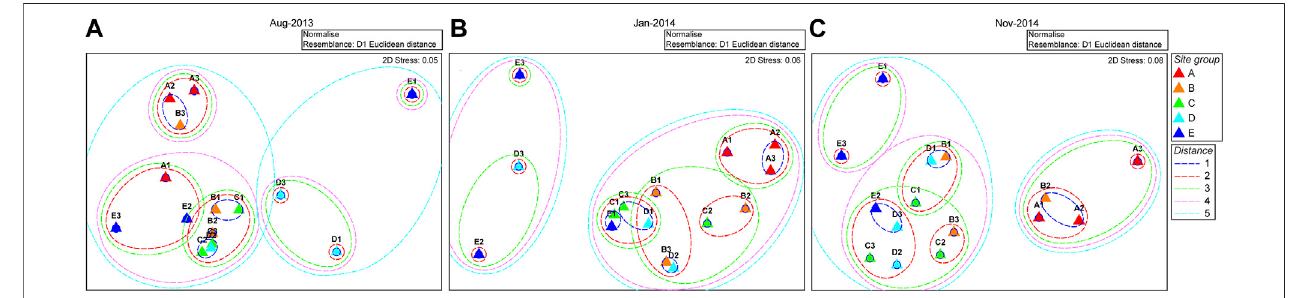
FIGURE 6 | The multi-scaling analysis biplots for monitoring sites in Gonghu Bay based on the Euclidean distance matrices of sensitive physicochemical parameters during the six sampling periods from 2013 to 2014. The classi fi cation of monitoring sites was based on three levels (1, 2, 3, 4, and 5).